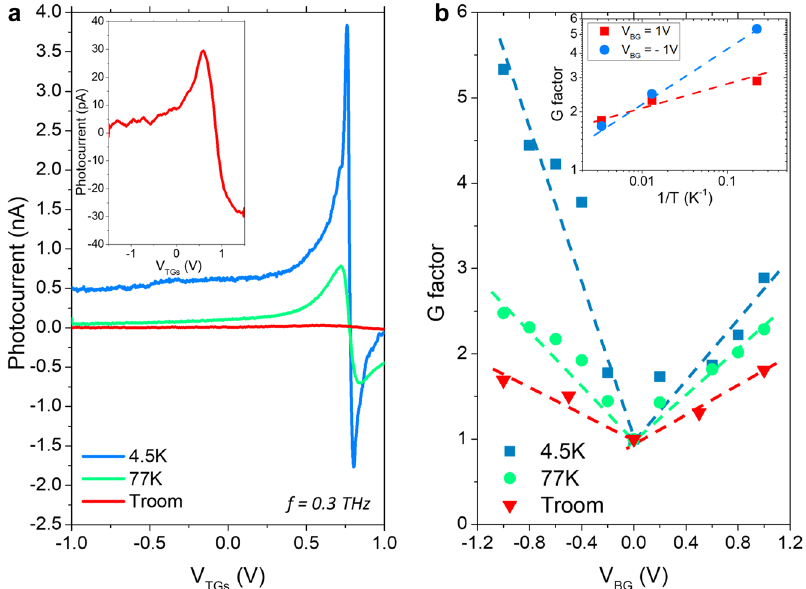
Figure 4: Temperature dependent THz